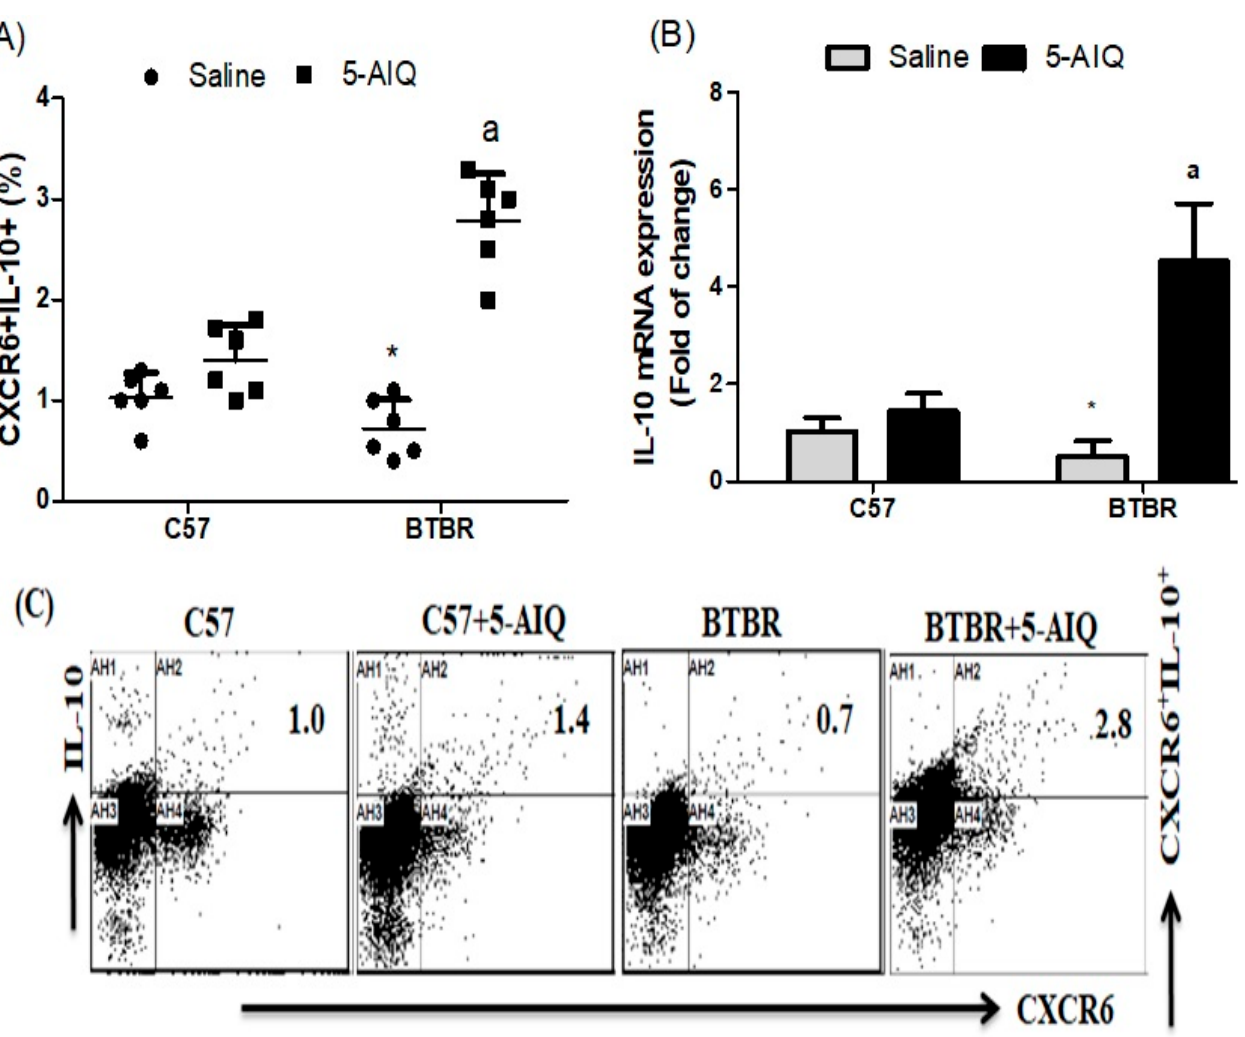
Figure 3. Effects of 5-AIQ on expression of IL-10 in C57 and BTBR mice. ( A ) Flow cytometry analysis of intracellular